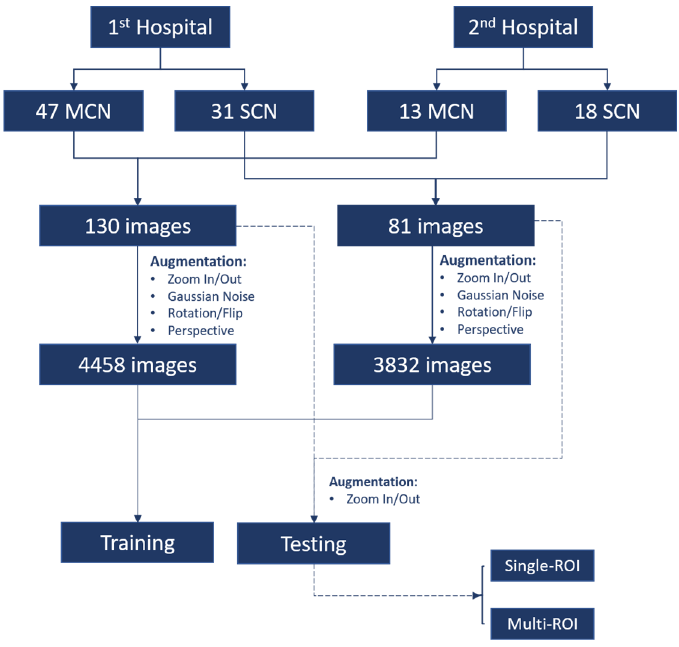
Figure 2. Diagram of data preparation and preprocessing. There were 109 patients, including 60 mucinous cystic neoplasm (MCN) patients and 49 serous cystic neoplasm (SCN) patients providing 130 and 81 endoscopic ultrasonography images for MCN and SCN, respectively.